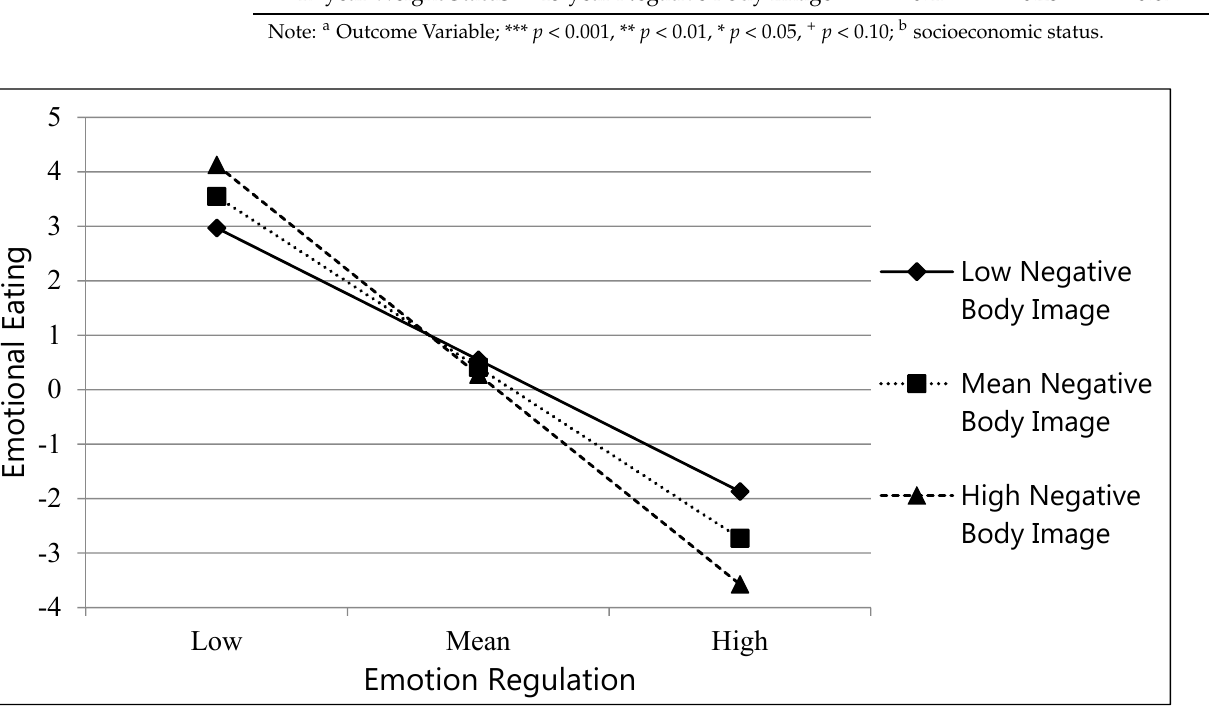
Figure 1. Emotion regulation x negative body image interaction predicts emotional eating. Table 2. Regression analysis on associations between 7yr emotion regulation, 15yr weight status, 15yr negative body image, and 17yr emotional eating.